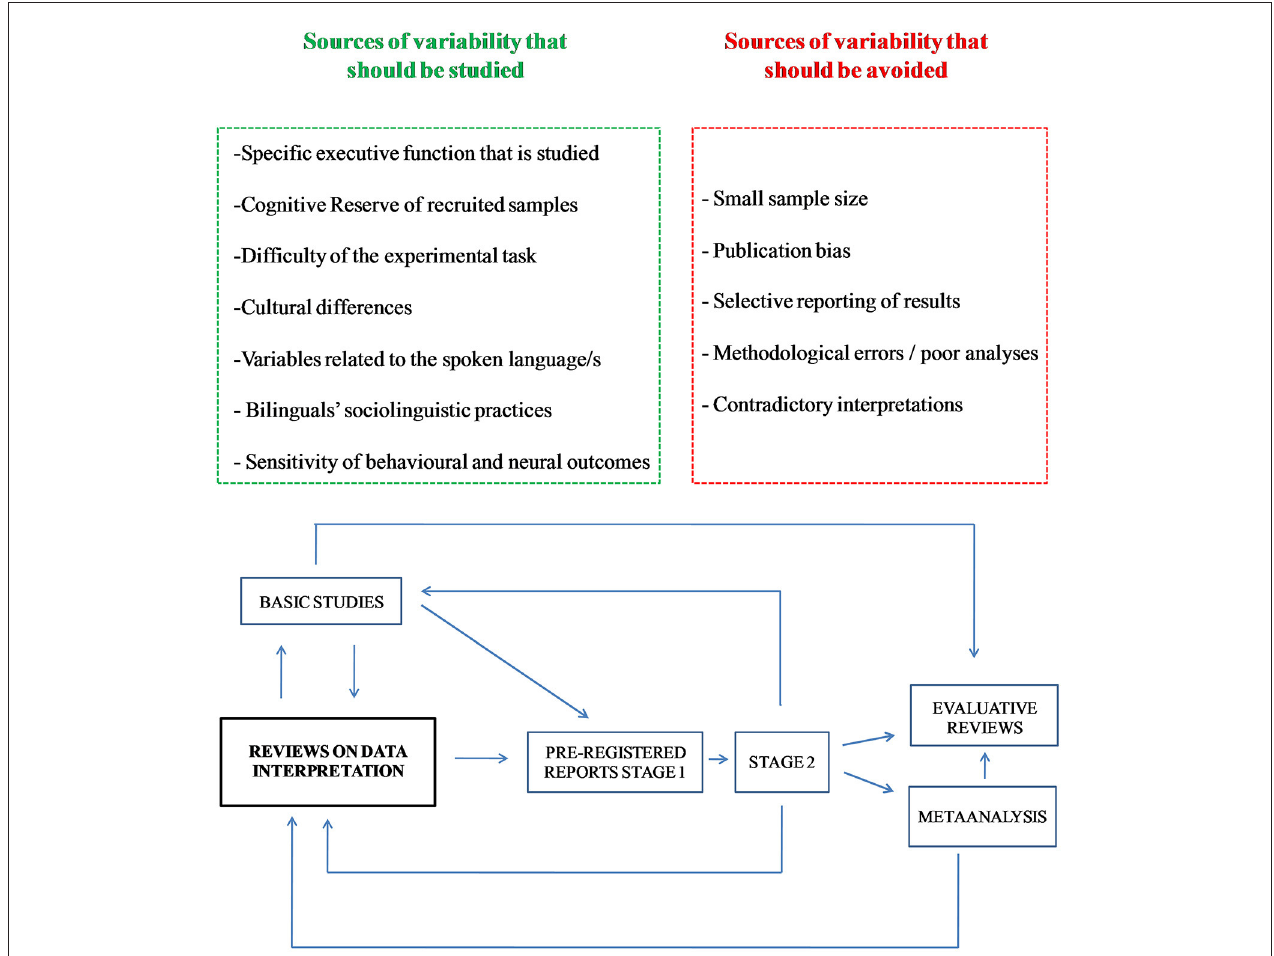
FIGURE 1 | Bilingualism and executive functioning: studying results variability and improving results interpretability. Sources of results variability (top panel); how “Reviews on data interpretation” can increase the reliability and interpretability of results (bottom panel). Bidirectional interaction between different types of scientific articles will help advance research. For instance, “Reviews on data interpretation” feed the hypotheses in “Pre-registered reports, Stage 1” and, at the same time, results from “Stage 2” may modify the hypotheses formulated in “Reviews on data interpretation.” The term “basic studies” refers to research that investigates neural modulations under experimental conditions in young and/or elderly samples.